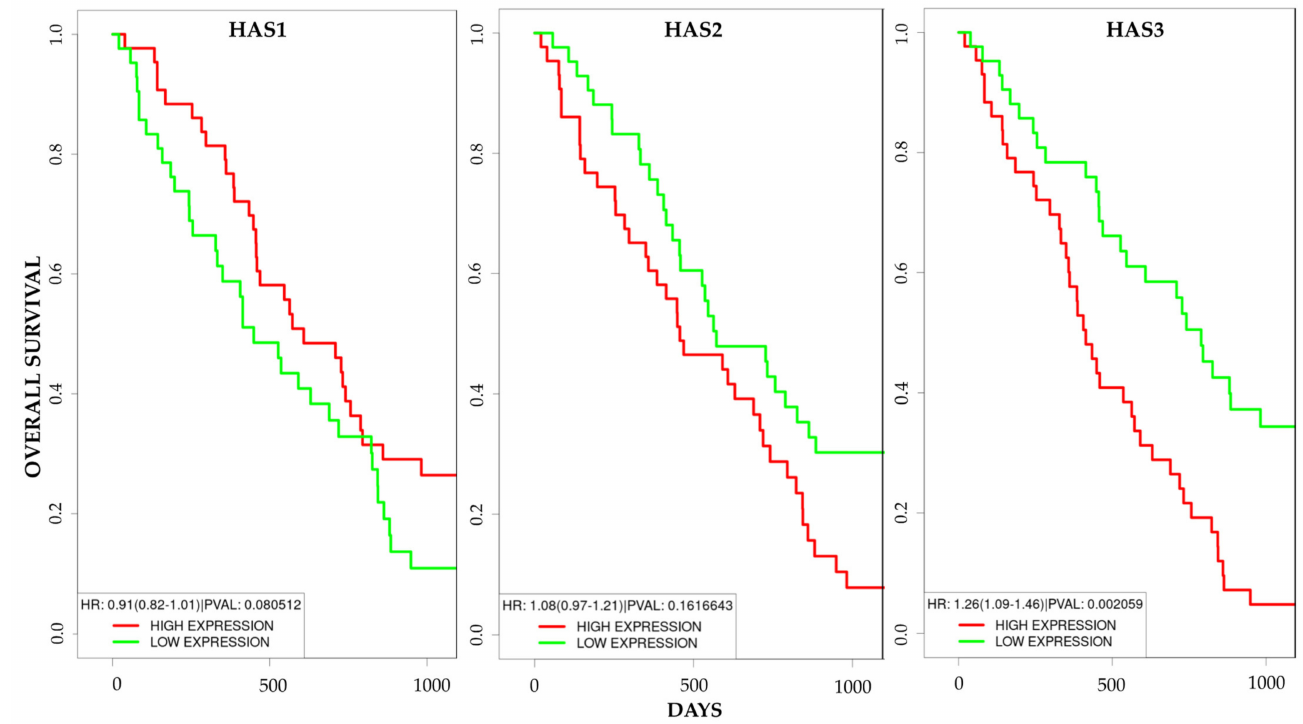
Figure 8. Patients’ clinical outcomes on the basis of HAS1 , HAS2 and HAS3 mRNA expression in MPM cancer. HAS1 and HAS2 expression is not correlated to MPM patients’ survival rate, whereas high HAS3 mRNA expression is correlated to a lower survival rate of mesothelioma patients as determined by using the PROGgene V2 database. p <